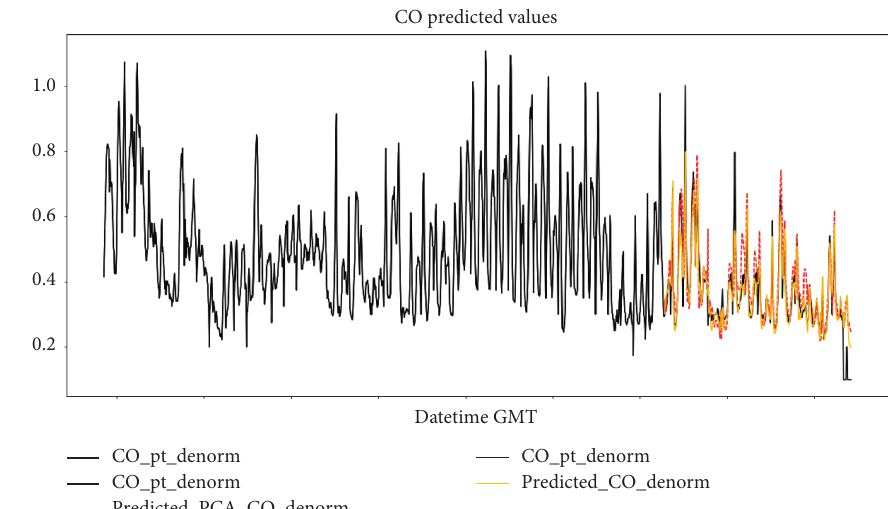
Figure 8: Forecasts of carbon monoxide measurements in California using the produced SVR forecasting models. The black line shows the observed values, whereas the red and yellow lines show the produced